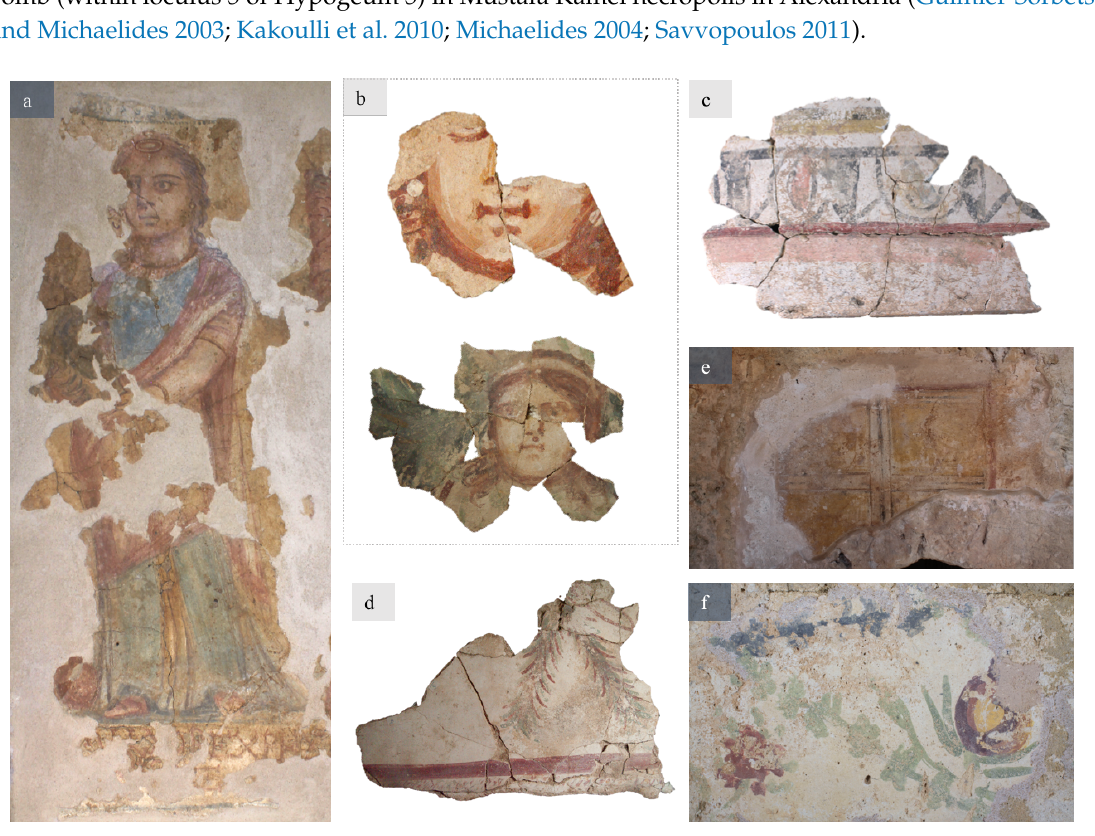
Figure 6. Examples of funerary decoration featuring figurative paintings, fragments and in situ paintings featuring common decorative motifs: ( a ) a figure painted on a limestone slab from Tomb 3510; ( b ) two faces reconstructed from fragments from the tomb in Costis Palamas square; ( c ) a fragment displaying an egg and dart pattern, recovered from Tomb 3882; ( d ) a fragment with garlands recovered from Tomb Annabelle 47; ( e ) painting of a door in Tomb 6; ( f ) floral decoration in the tomb at Glyky